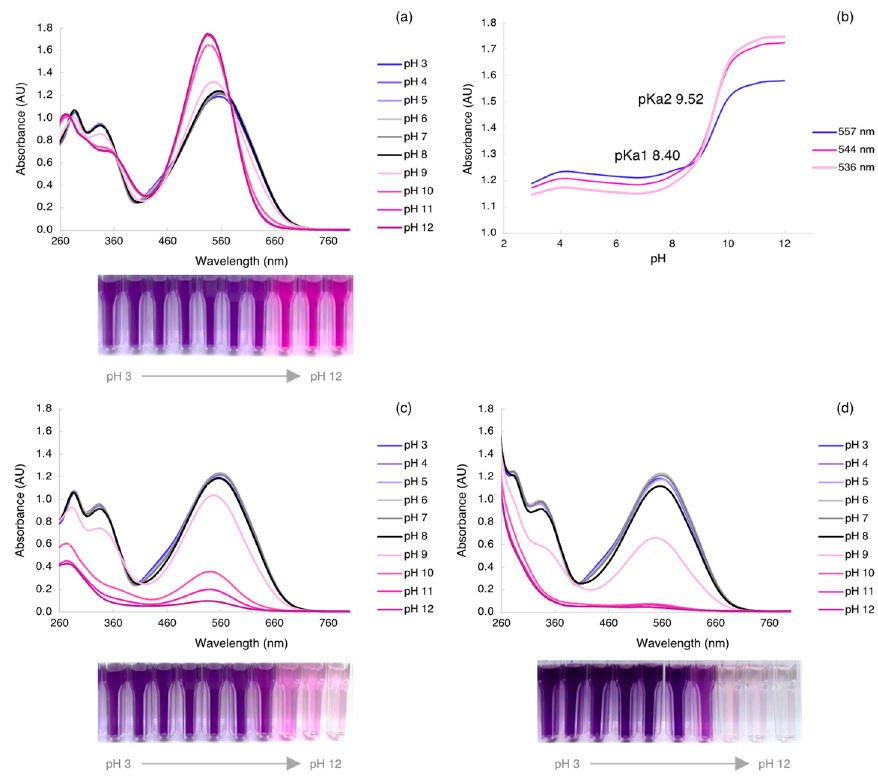
Figure 2. ( a ) UV-vis spectra of AzoIz.Pip from pH 3 to 12 immediately after solution preparation and ( b ) corresponding pKa calculation in the function of pH at 557 nm ( λ max at pH 3), 544 nm ( λ max at pH 9), and 536 nm ( λ max at pH 12); UV-vis spectra of the solutions ( c ) after 7 h and ( d ) 24 h of the preparation. Table 3. Maximum wavelength ( λ max ) values and molar extinction coefficient ( ε ) for AzoIz.Pip from pH 3 to 12 using Britton–Robinson buffered